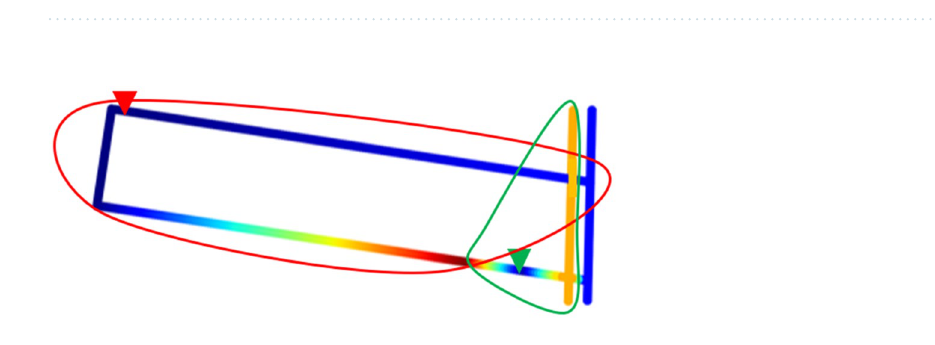
Figure 13. The results of location selection by the two monitoring methods.